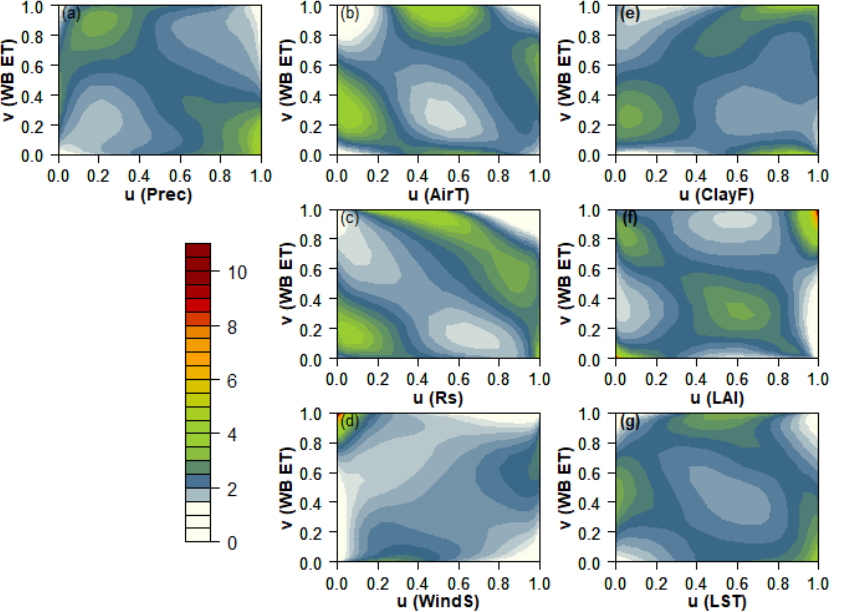
Figure A5. Catchment-based empirical Copula densities between the surface water balance ET estimate and meteorological variables (left and middle panels) and land-surface variables (right panels). The datasets are the same as in Figures A3 and A4. The sample size is 146 data tuples for all the variables. In all the panels ( a – g ), water balance ET (y-axis) are plotted against meteorological and land-surface variables (x-axis).